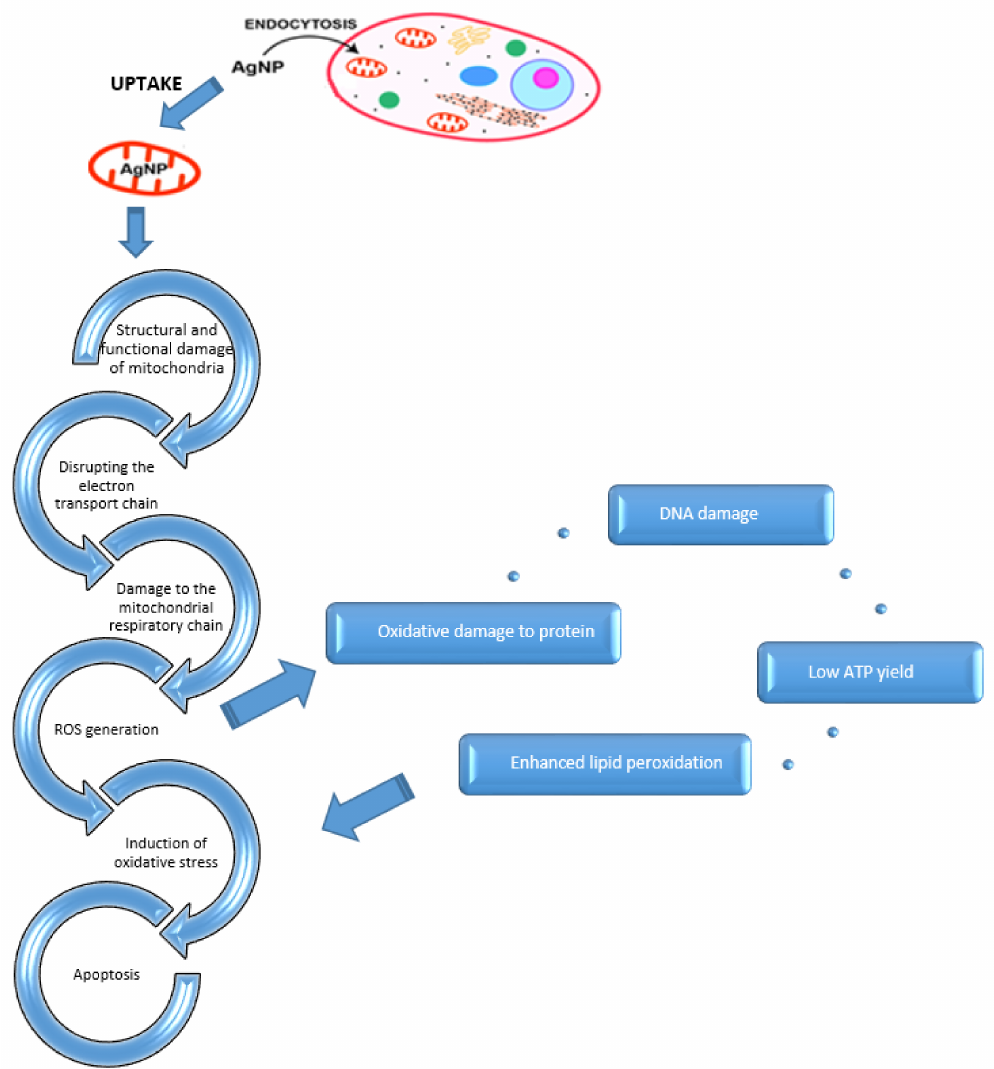
Figure 1. A possible mechanism of apoptosis induced by